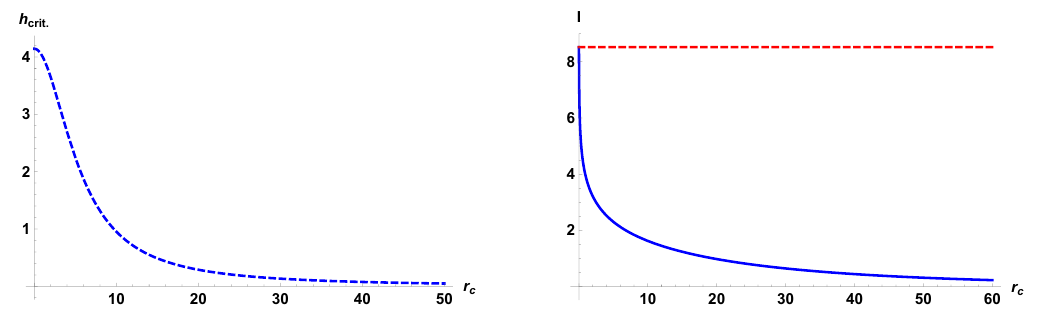
10 Figure 11 . Left ) h crit . as a function of r c for ‘ = 10 and d e = 1 . It is evident that h crit . is a decreasing function of r . Right ) HMI as a function of r c red dashed curve indicates the HMI for the zero cutoff case given in eq. (4.3) and the solid blue curve is the HMI for the finite cutoff case, i.e. eq. (4.5). It is evident that the HMI is a decreasing function of the cutoff r c